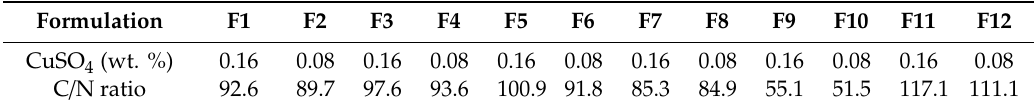
Table 1. Carbon / nitrogen ratios and copper(II) sulfate concentrations employed for formulations of twelve solid